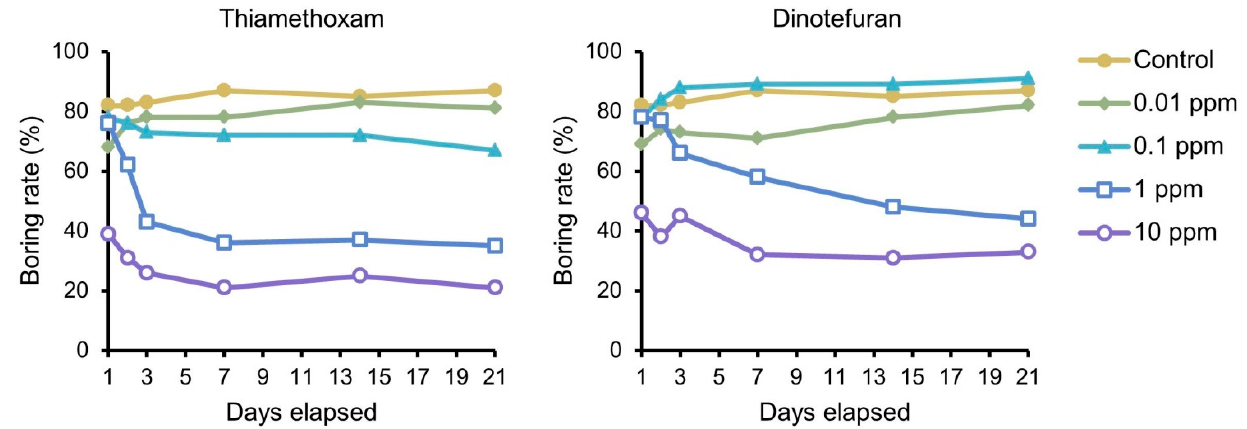
Figure 2. Aromia bungii neonates’ diet–boring rate in the dietary toxicity test. The survival rate (52% ± 15% and 40% ± 12%, respectively) was lower in the 1 and 10 ppm thiamethoxam groups compared with the control group (73% ± 19%) ( t = − 2.8, p < 0.01 and t = − 4.5, p < 0.001, respectively) (Figure 3). In other treatment groups, the survival rate did not differ from that of the control group. Despite a careful search, some neonates ( ≤ 11%) could not be detected at day